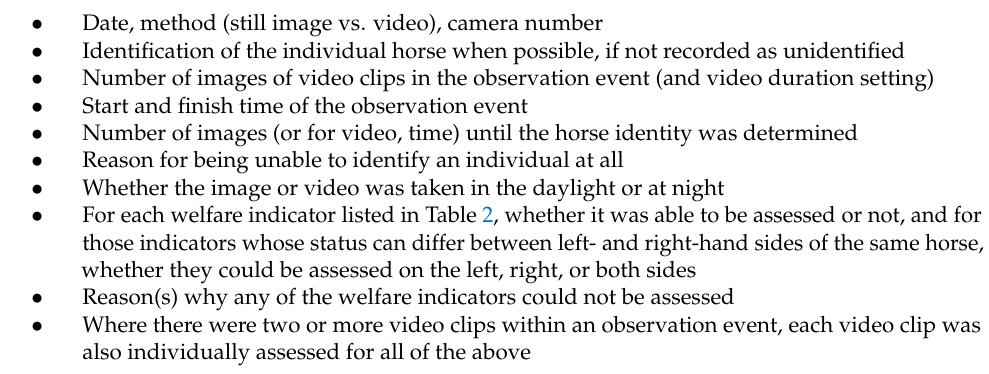
Table 3. Details recorded from each observation